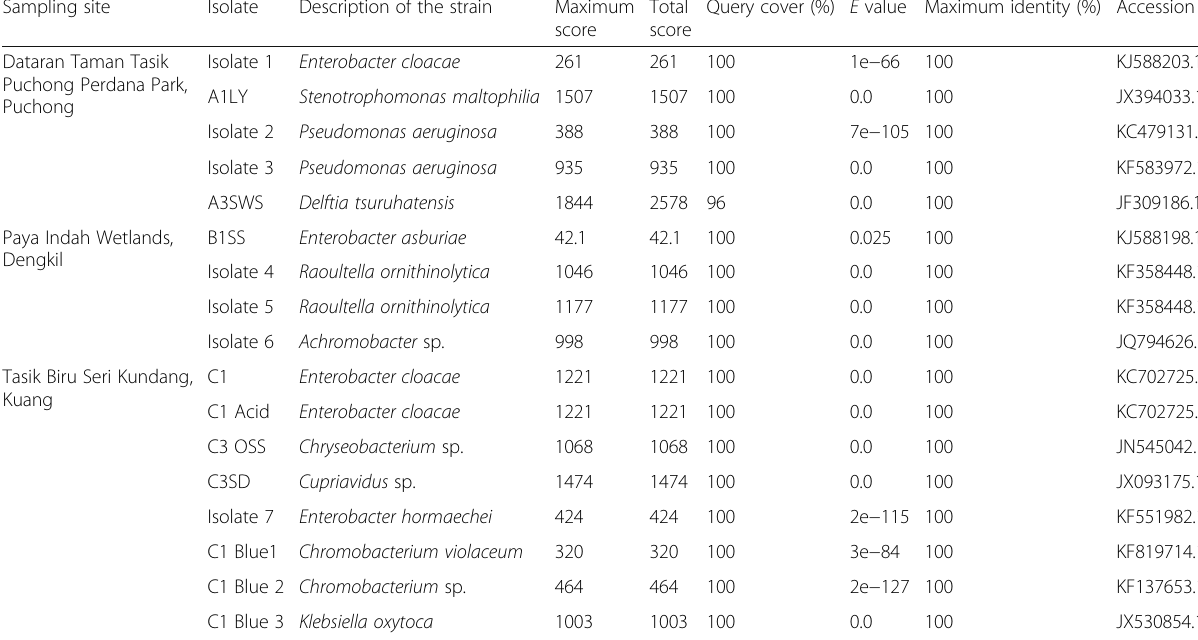
Total Query cover (%) E value Maximum identity (%) Accession score score